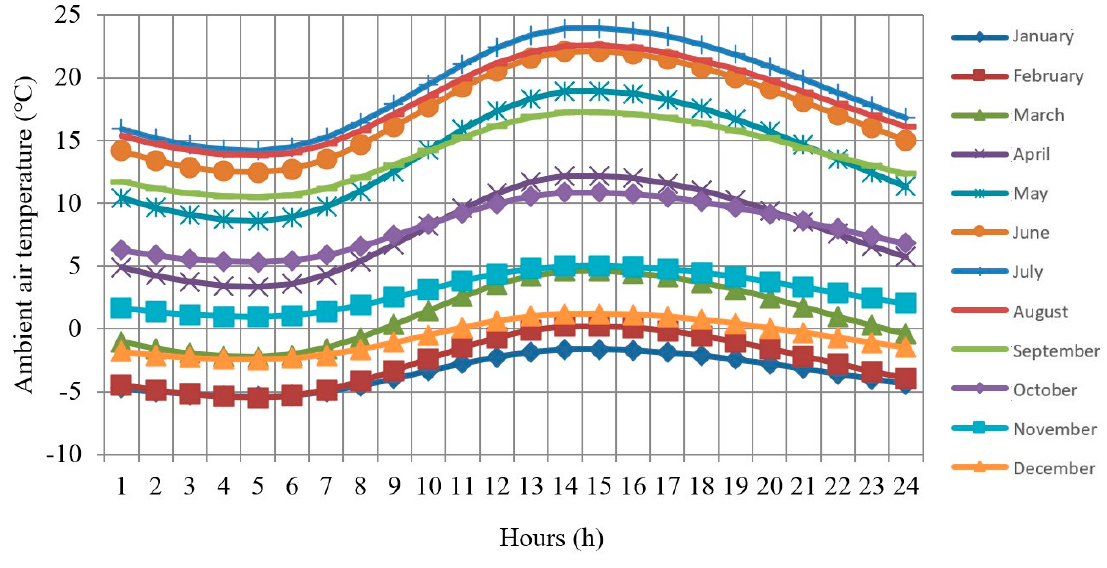
Figure 2. Distribution of average hourly ambient air temperature for averaged days of different months of the average year for Warsaw.